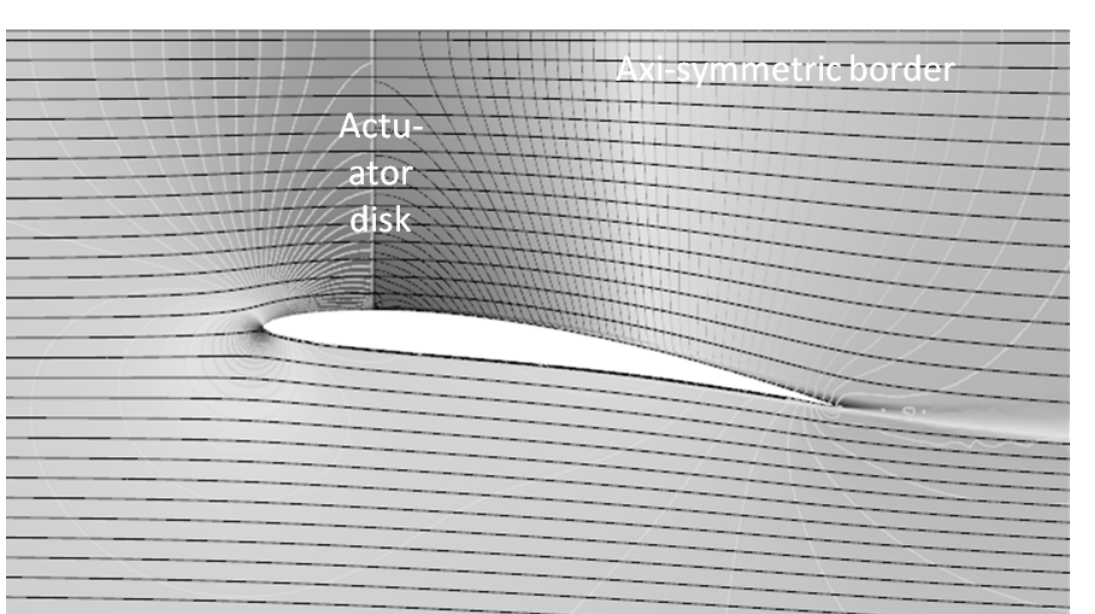
Figure 3. Cross-section (x-r plane) of the Hansen DAWT. Black lines: Streamlines. Lighter colored lines: iso-pressure lines. Note pressure drop across the actuator